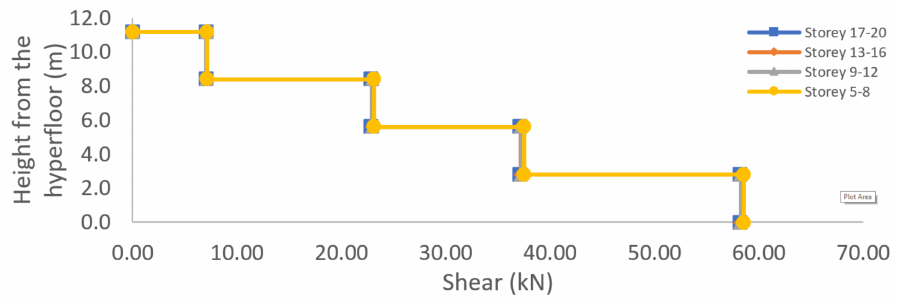
Figure 10. Shear experienced by the shearwall segments in N–S direction of the long modules under factored gravity-load combination 1.25 D + 1.5 L + 1.0